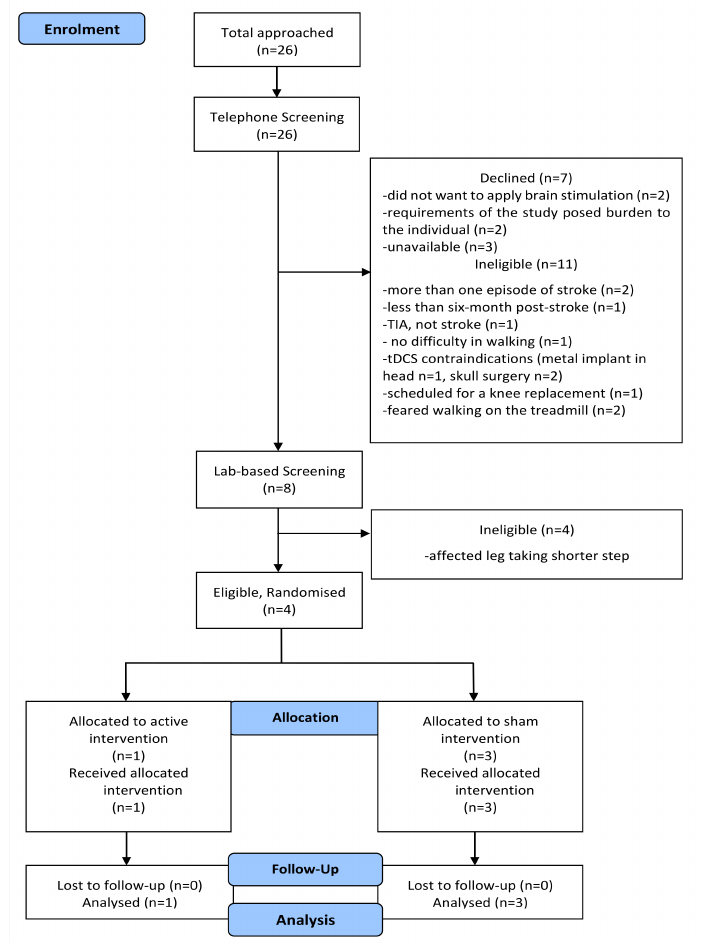
Figure 3. CONSORT study flow